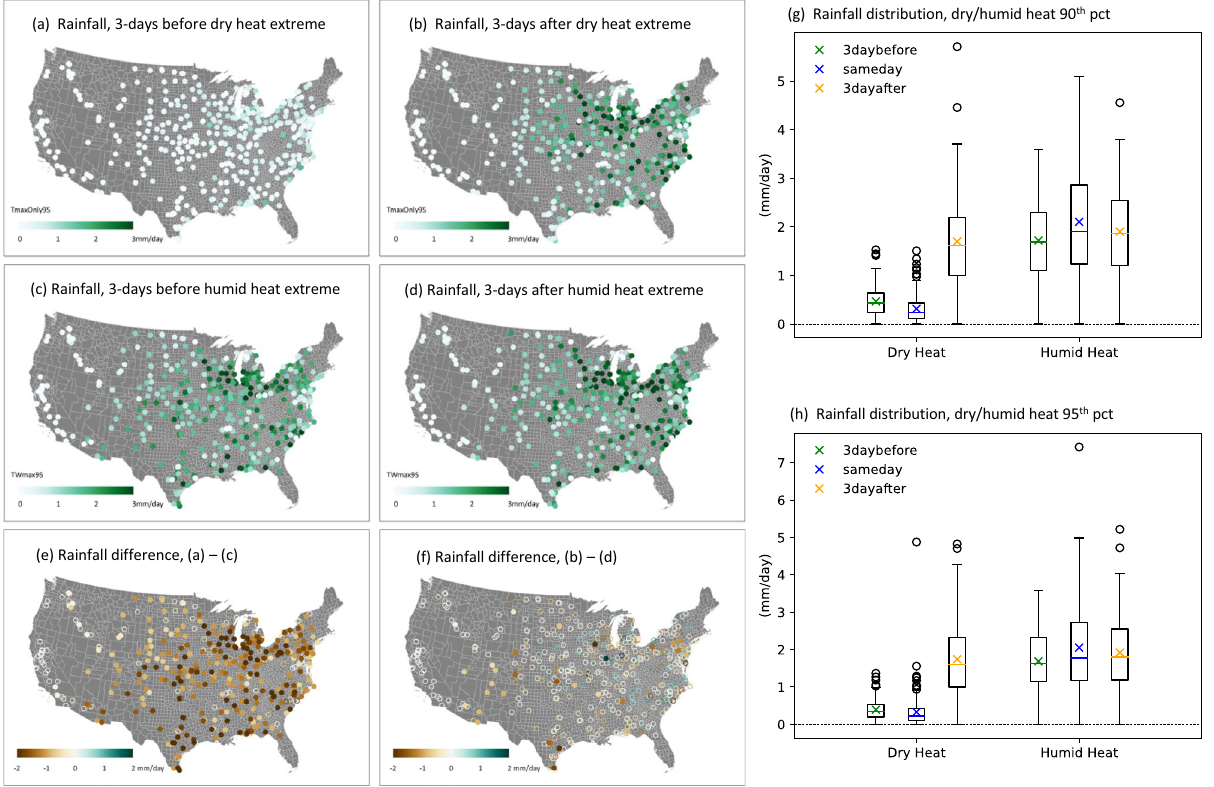
Figure 6. Rainfall before and after the extreme heat events. Rainfall averaged over 3 days before ( a ) extreme dry heat days and ( c ) extreme humid heat days, and ( e ) their differences. ( b ), ( d ) and ( f ) are the same as ( a ), ( c ) and ( e ) except for rainfall averaged over the 3 days following the extreme dry and humid heat days. Solid (open) circles in ( e ) and ( f ) indicate significant (non-significant) differences at the 95% confidence level using two-sided Student t-test. Rainfall units are in mm/day. ( g ) and ( h ) Box plots showing precipitation distribution for all stations with significant negative regression coefficients in Fig. S5a for the 90th percentile extreme heat threshold ( g ), and in Fig. 3a for the 95th percentile threshold ( h ), for 3-days before (green marks), same day (blue), and 3-days after (orange) the extreme dry and humid heat event. The maps are made with ArcGIS Pro 2.2.0 with the US base map downloaded from Census Bureau, https:// catal og. data. gov/ datas et/ 2019- carto graph ic- bound ary- shape file- curre nt- census- tract- for- united- states- 1-